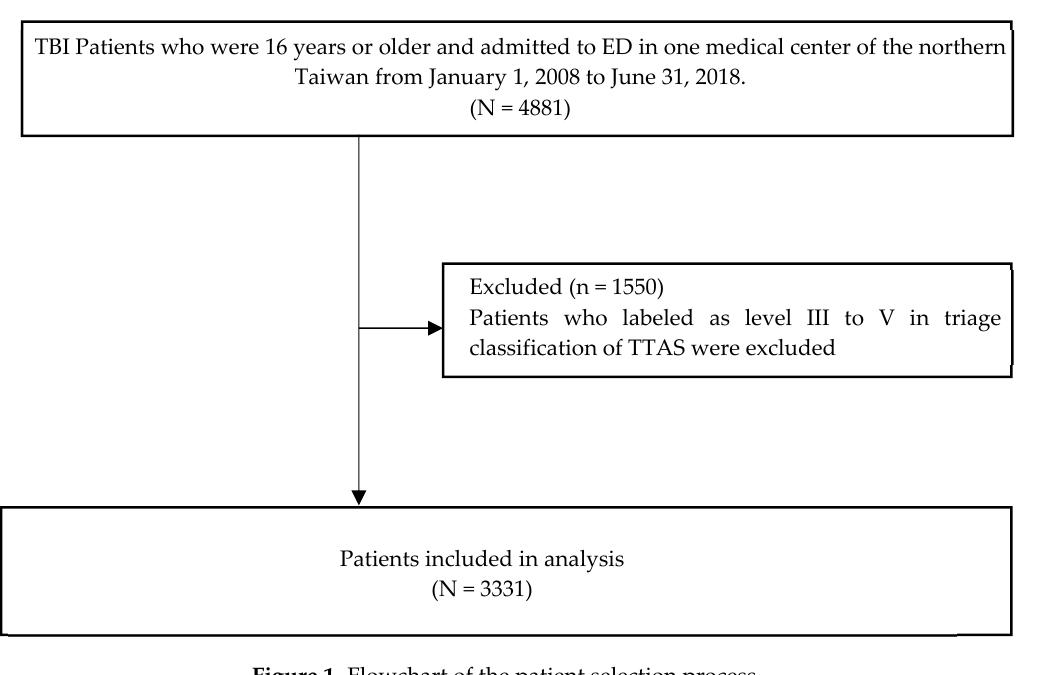
Figure 1. Flowchart of the patient selection process. Table 1. Sample characteristics and differences in mortality of patients a,b